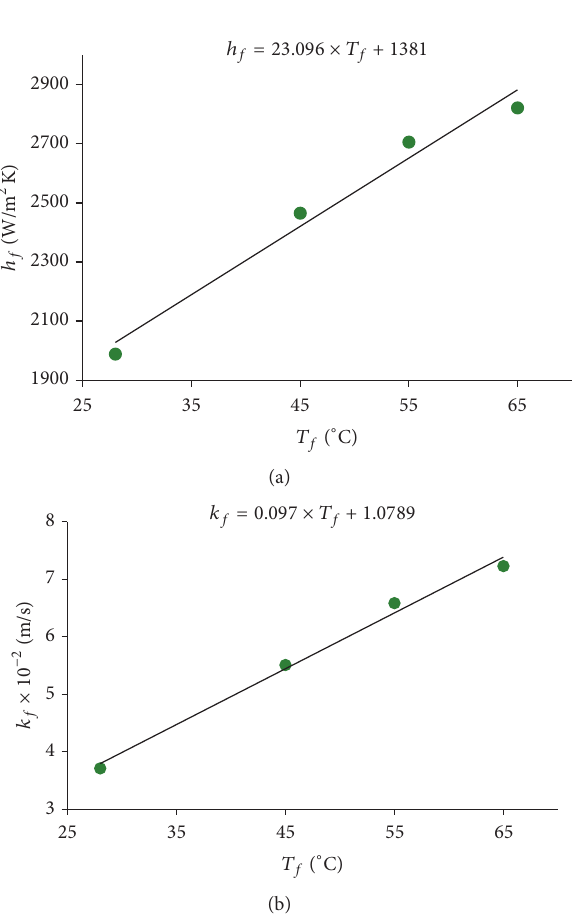
Figure 6: The pure water (a) heat ( ℎ 𝑓 ) and (b) mass ( 𝑘 𝑓 ) transfer coefficients versus the feed temperature at a flow rate of 58.7 L/h.